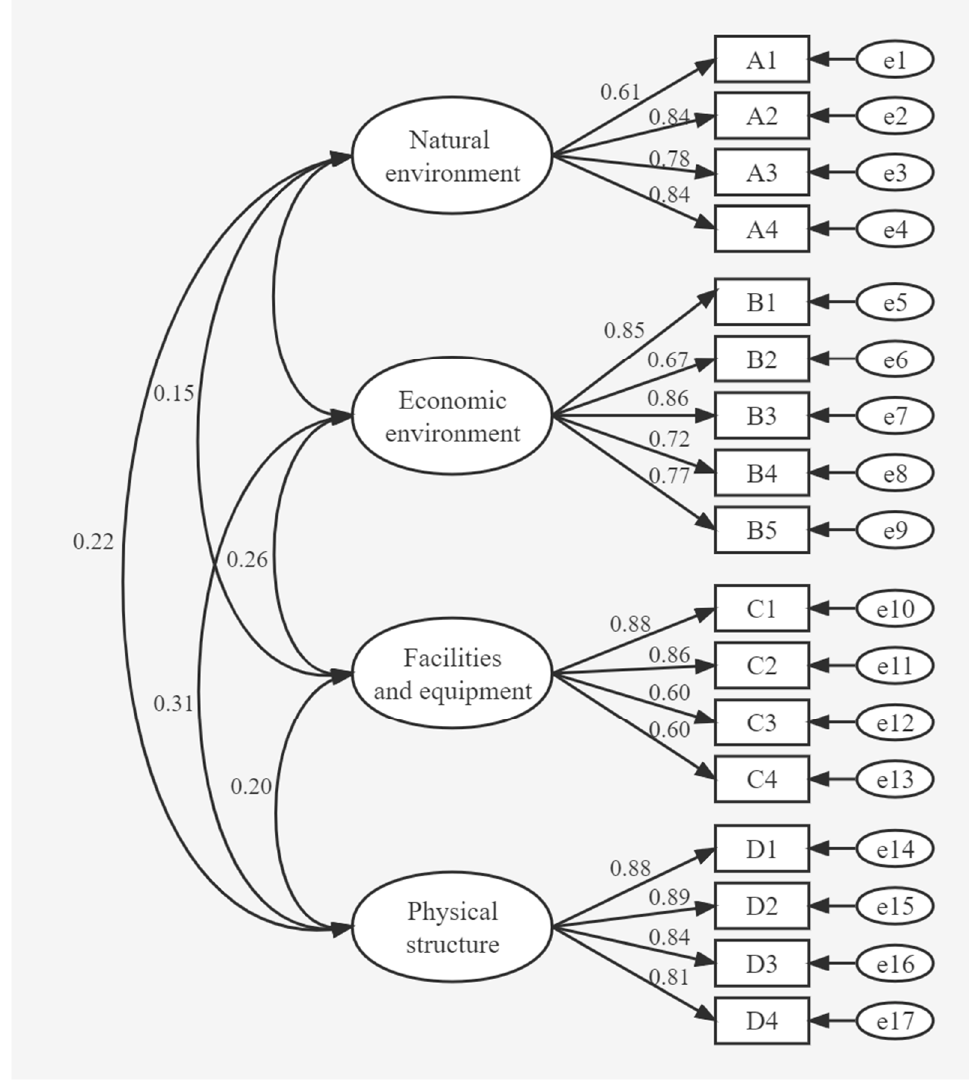
Figure 2. Path coefficients of the first-order structural equation model of underground public space (UPS).